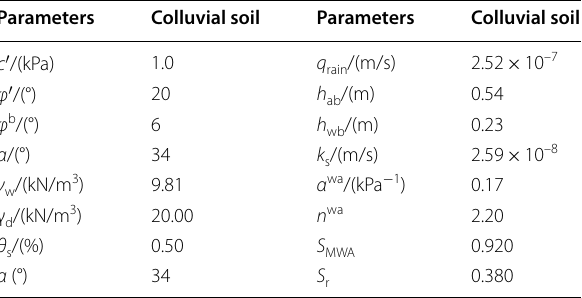
Table 2 Parameters for Bay Area landslide (Chen et al. 2017) Parameters Colluvial soil Parameters Colluvial